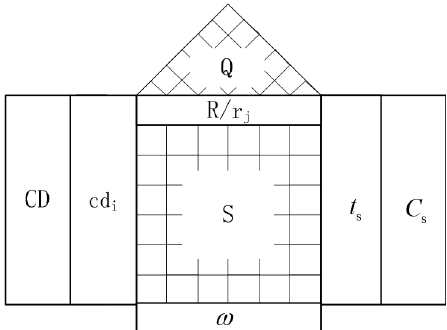
Figure 1. Relationship between customer demands and product development time and